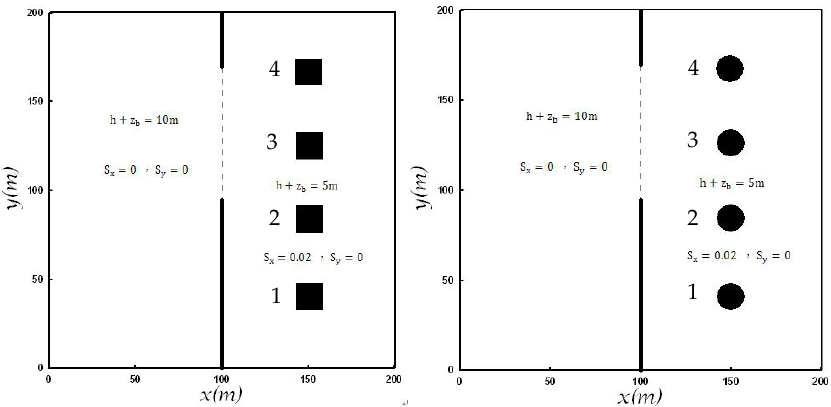
Figure 14. Geometry of a dam break surge with four aligned square and circular cylinders down- stream.